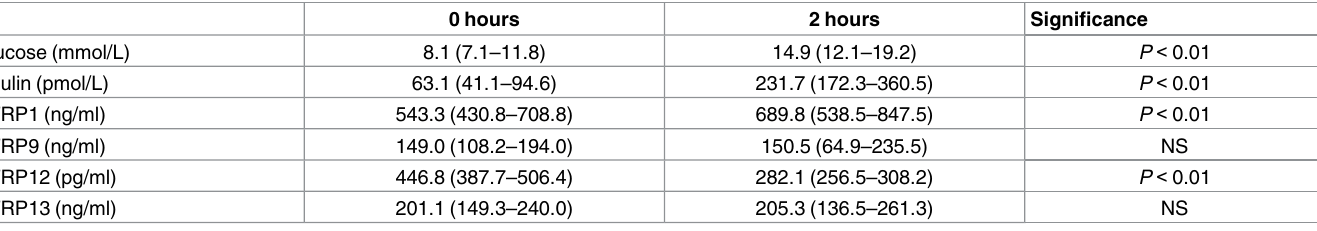
Table 2. Effects of a 2 hour 75g OGTT on serum glucose, insulin, CTRP1, CTRP9, CTRP12 and CTRP13 concentrations in T2DM subjects (n = 124). 0